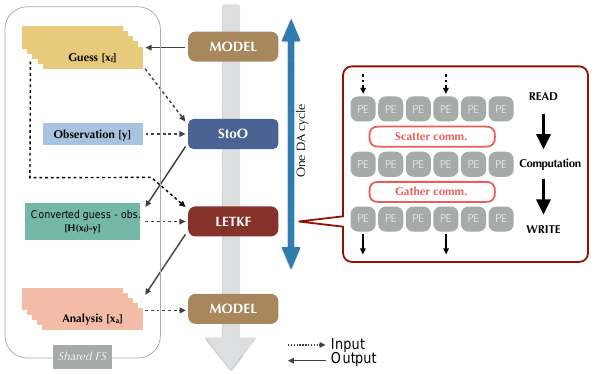
Figure 1. Schematic flow of the DA system with the